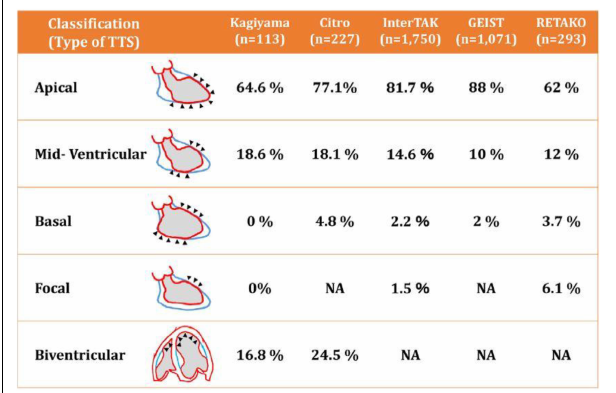
FIGURE 5 | Diagrammatic depiction of the most frequent patterns of transient takotsubo cardiomyopathy (52). Note that more than 95% of the cases in several large registry databases were apical or mid-ventricular. TTS, transient takotsubo cardiomyopathy. Source: Okura (52). Used with